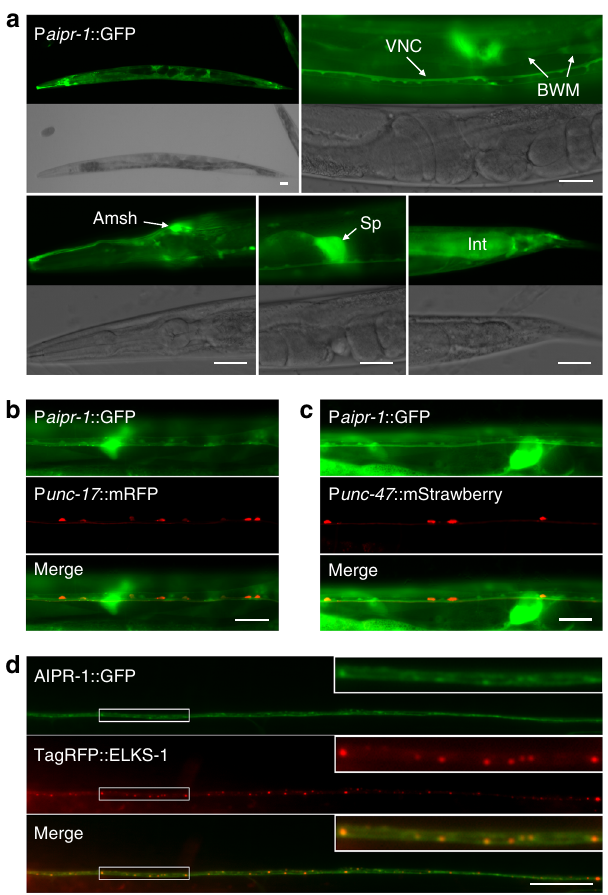
Fig. 3 Expression and subcellular localization of AIPR-1. a A GFP reporter, expressed under the control of genomic DNA upstream of the aipr-1 initiation site, showed expression in many cell types, such as motor neurons along the ventral nerve cord (VNC), body-wall muscle cells (BWM), amphid sheath cells (Amsh), spermatheca (Sp), and the intestine (Int). b , c AIPR-1 is expressed in all acetylcholine and GABA motor neurons in the ventral nerve cord. Acetylcholine and GABA motor neurons were labeled by expressing mRFP and mStrawberry under the control of P unc-17 and P unc- 47 , respectively. Images were taken from a segment anterior b and posterior c to the vulva. d , AIPR-1::GFP displayed both diffuse and punctate distribution along the dorsal nerve cord, and the GFP puncta colocalized with the presynaptic marker TagRFP::ELKS-1. Images were taken from a dorsal segment anterior to the vulva. Scale bars, 20 µ m a – c and 10 µ m d,